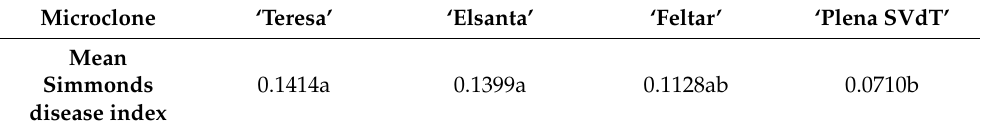
Table 7. Differences in the rate of Phytophthora disease development expressed by the mean Simmonds disease index. Means marked with the same letter do not differ significantly at p ≤